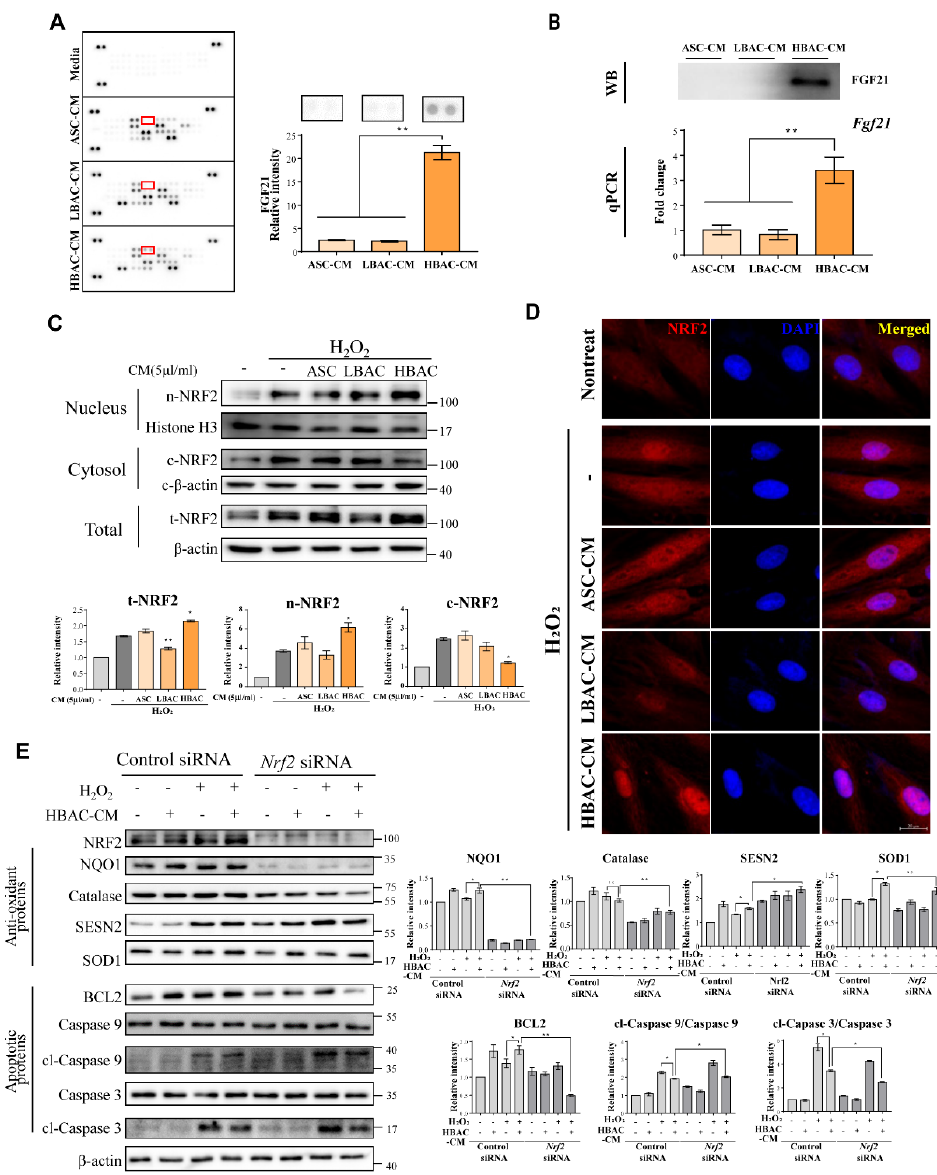
Figure 5. Brite adipocyte FGF21 attenuates cardiac IR injury by modulating NRF2. ( A ) Elevated FGF21 secretion from beige adipocytes in the adipokine array. ( B ) Validation of FGF21 protein expression in ASC, LBAC, or HBAC-derived CM by western blot analysis (up) and FGF21 gene ex- pression in ASC, LBAC, or HBAC using qPCR (down). ( C ) Oxidative stress is alleviated by NRF2 translocation. * p < 0.05 and ** p < 0.01 vs. H 2 O 2 -treated group. ( D ) Representative images of NRF2 immunofluorescence and DAPI staining. Scale bar = 200 μ m. ( E ) Effect of Nrf2 knockdown on the expression of oxidant and apoptosis-related proteins. The data are shown as the mean ± standard error of the mean ( n = 3). * p < 0.05, ** p < 0.01. cl means “cleaved form”. 3.6. Effect of Treatment with the Beige Adipocyte Secretion Factor FGF21 on Cardiomyocytes Under Oxidative Stress We investigated whether FGF21 confers beneficial effects on antioxidant and antiapoptotic factors in oxidatively stressed cardiomyocytes (Figure 6). The expression levels of antioxidative factors were upregulated according to FGF21 concentration, with enhanced NRF2 expression in H9c2 cardiomyocytes under H 2 O 2 -induced oxidative stress